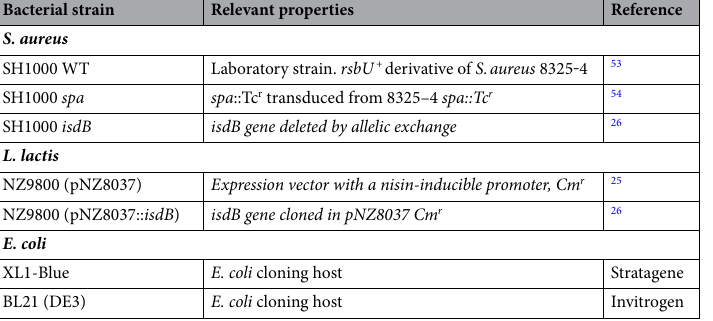
Table 1. Abbreviations used are as follows: Cm r , chloramphenicol resistance, Tc r , tetracycline resistance.